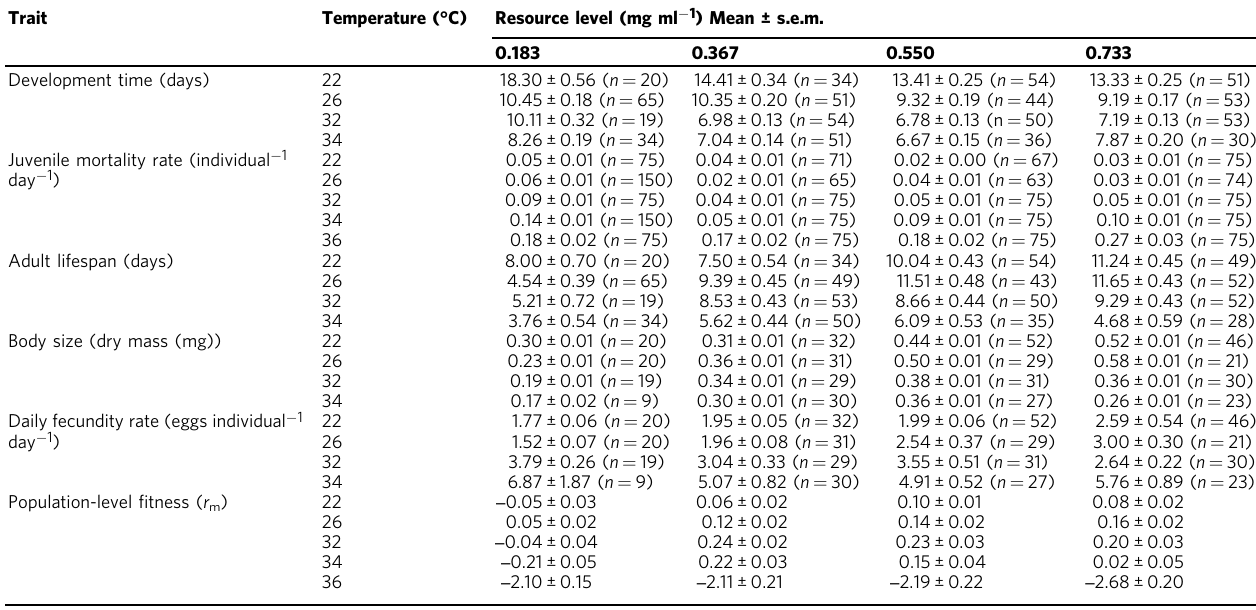
Table 2 Comparison of the effect of larval competition on the temperature-dependence of population fi tness ( r m ) and its component